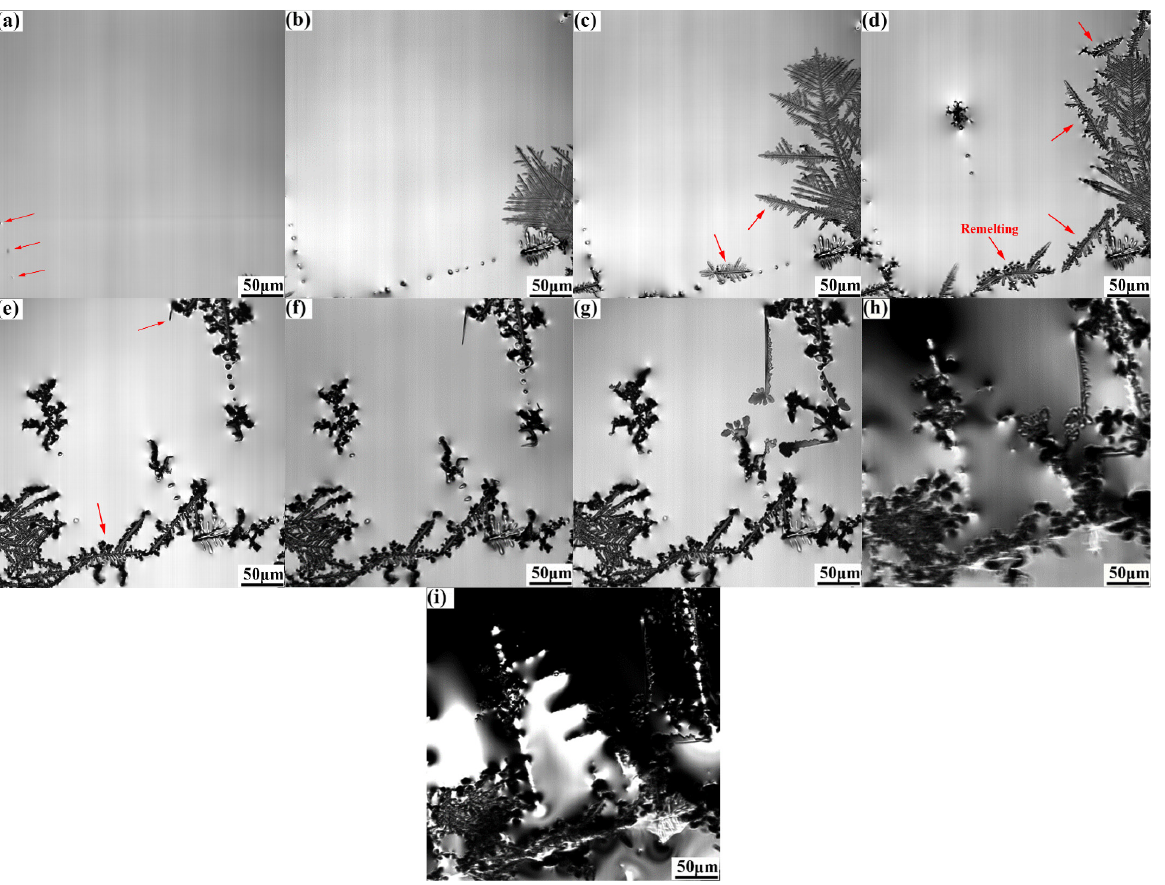
Figure 4. In situ observation of the microstructure evolution at the cooling rate of 1.5 °C/s: ( a ) 1302.1 °C, ( b ) 1270.5 °C, ( c ) 1267.0 °C, ( d ) 1264.5 °C, ( e ) 1177.2 °C, ( f ) 1166.1 °C, ( g ) 1105.7 °C, ( h ) 1046.6 °C, and ( i ) 1042.7 °C.